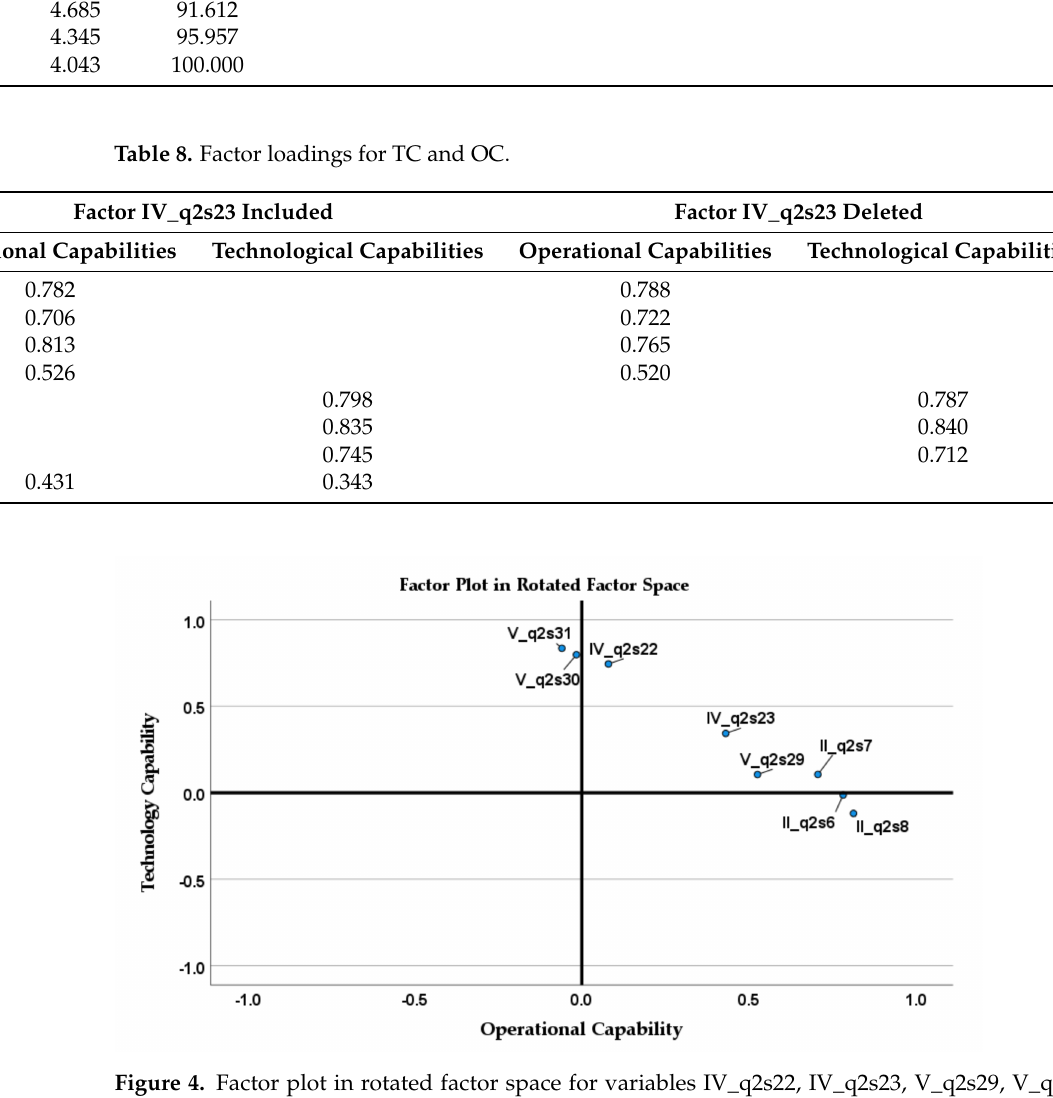
Figure 4. Factor plot in rotated factor space for variables IV_q2s22, IV_q2s23, V_q2s29,